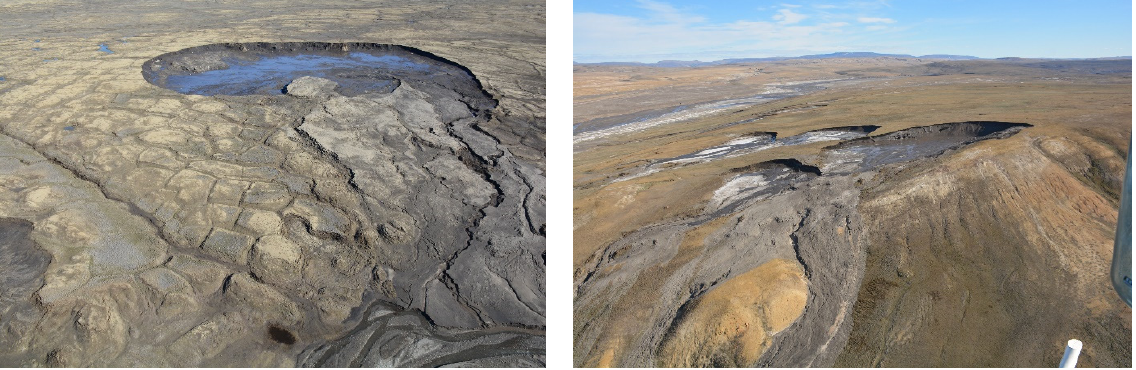
Figure 2. Field photos showing RTS activity in Ellesmere Island ( left ) and Axel Heiberg Island ( right ) acquired in years 2018 and 2016, respectively.